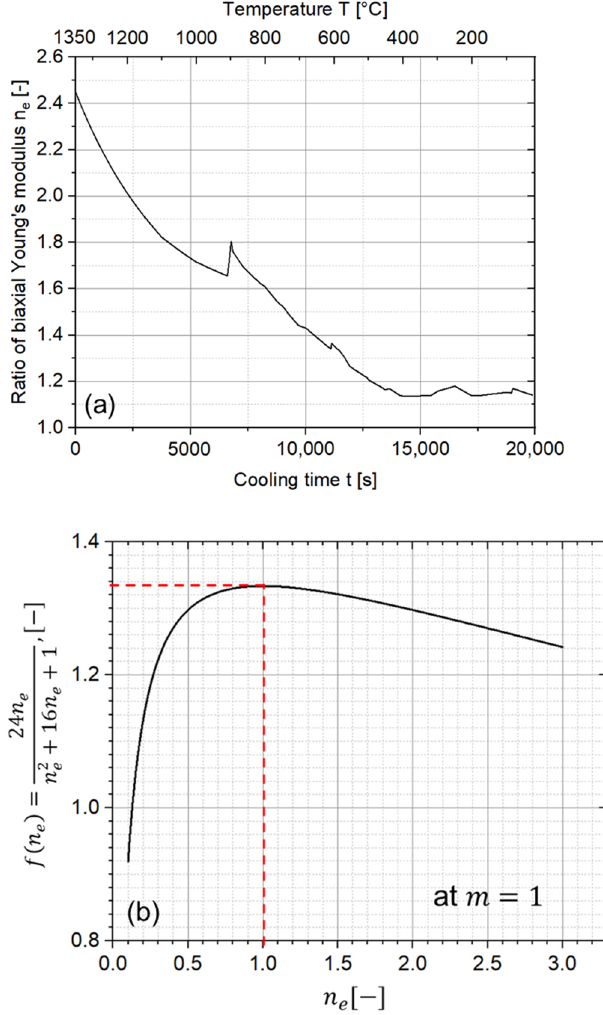
Figure 14. ( a ) The value of 𝑛 (cid:3032) during cooling. ( b ) Influence of 𝑛 (cid:3032) at 𝑚 = 1 based on Equation (5).